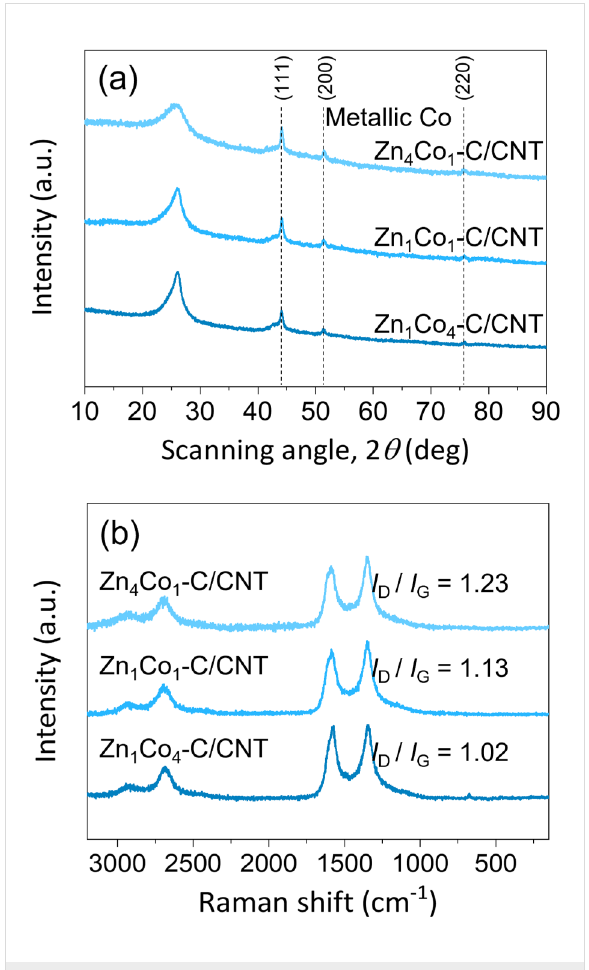
Figure 2: (a) XRD patterns and (b) Raman spectra of Zn x Co y –C/CNT composites.